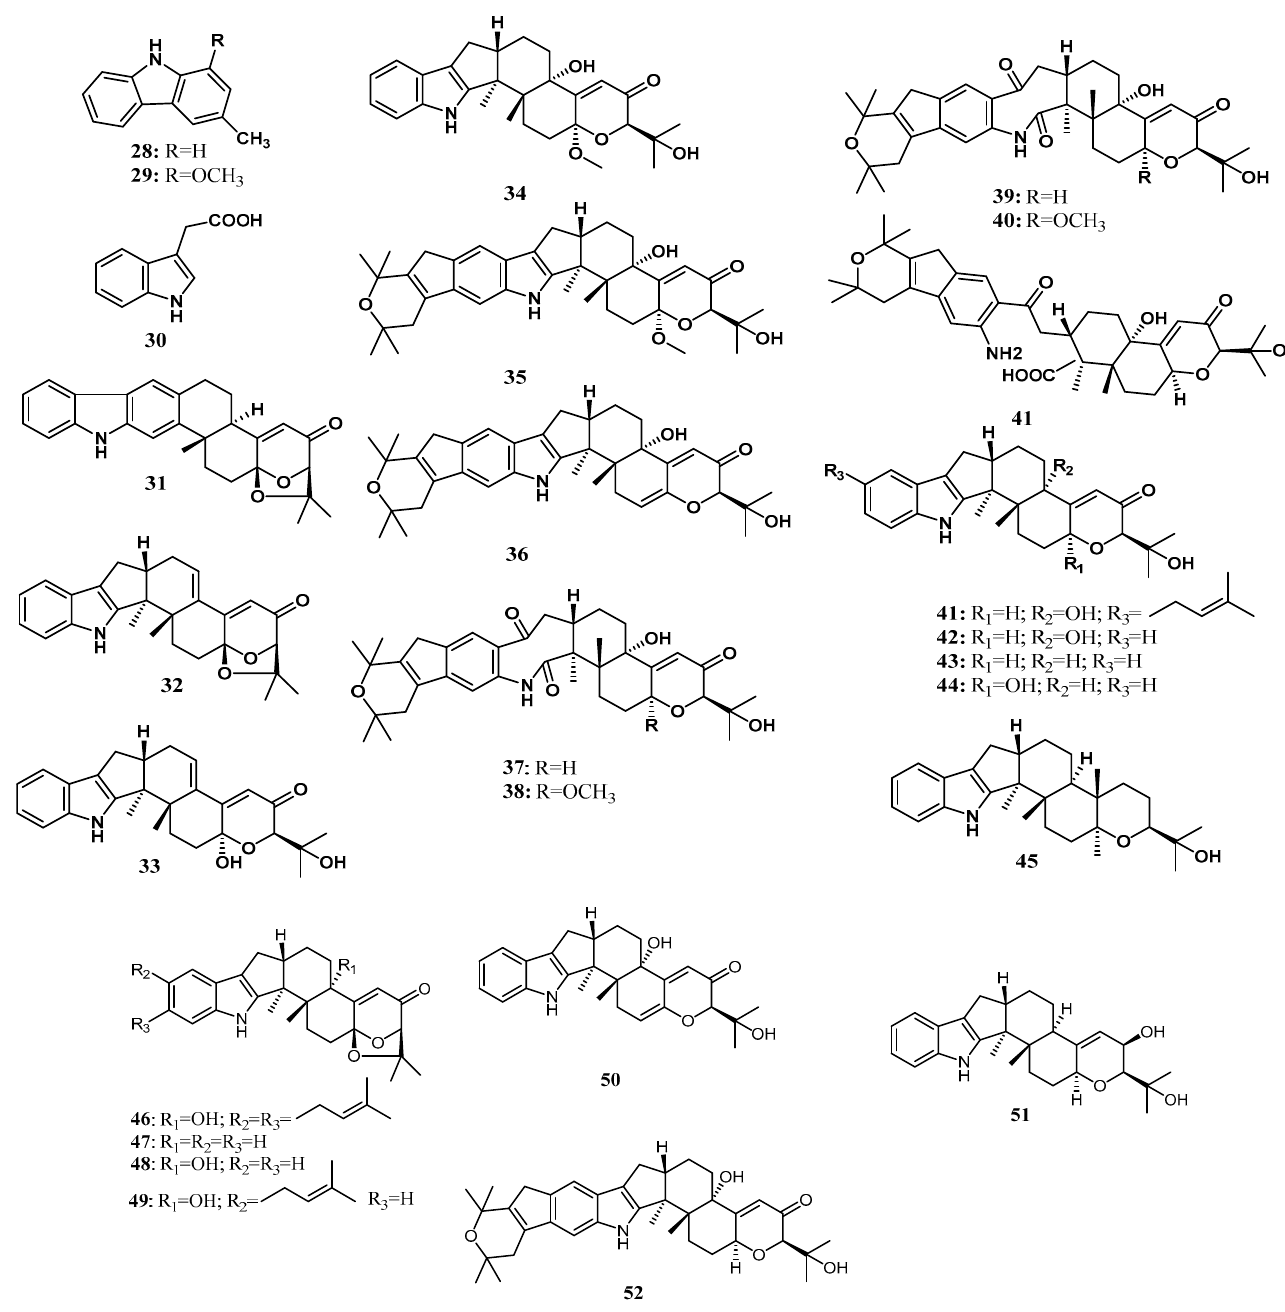
Figure 3. Alkaloid and indole diterpenoids from Zingiberaceae endophytes.